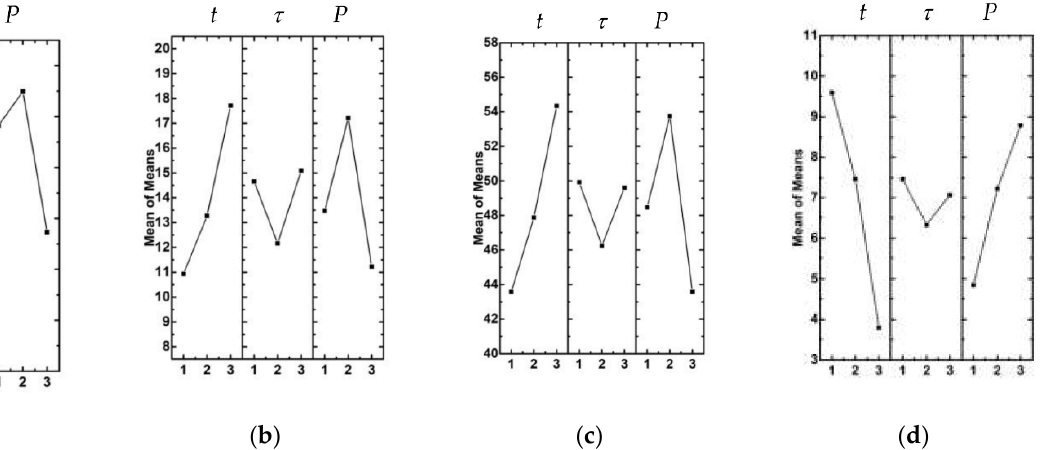
Figure 2. Dependencies of the mechanical and structural characteristics based on USW parameters: